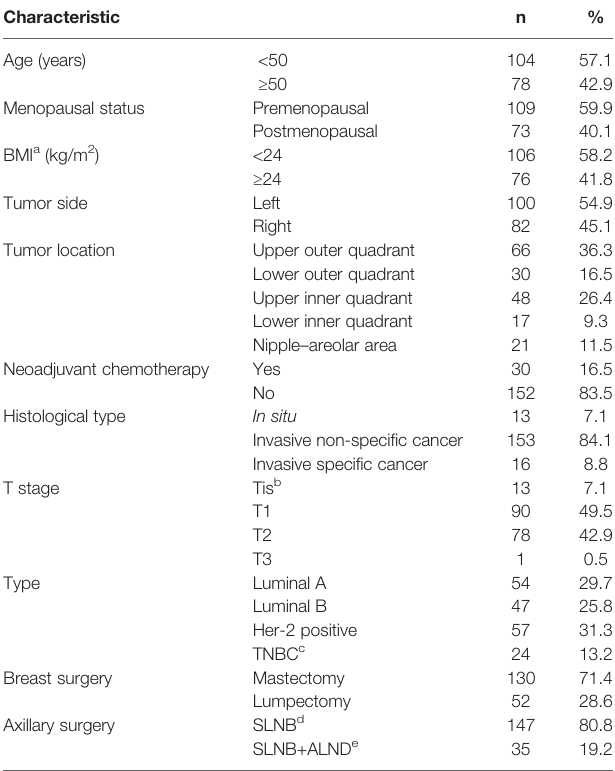
TABLE 1 | Demographic and clinical characteristics of the 182